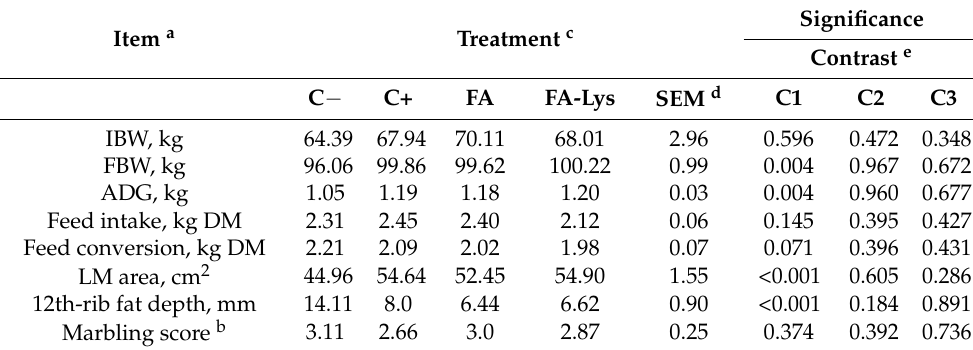
Growth performance and carcass traits of finishing pigs supplemented with FA or